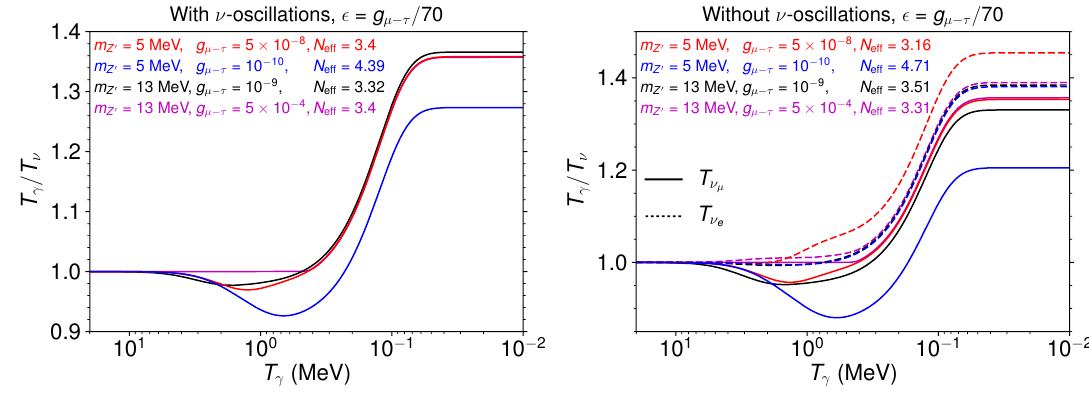
Figure 4 . The evolution of T (cid:13) =T (cid:23) for several choices of the Z 0 mass and L (cid:22) (cid:0) L (cid:28) gauge coupling, adopting the \natural" value for the kinetic mixing parameter, (cid:15) ’ g (cid:22) (cid:0) (cid:28) = 70. The solid lines denote T (cid:23) while the dashed lines correspond to T (cid:23) (cid:22) ;(cid:23) (cid:28) from rapid neutrino oscillations. In the right panel, neutrino oscillations are neglected. between neutrinos and the electromagnetic sector that might result from U(1) tions. We solve this set of equations starting from an initial condition of T